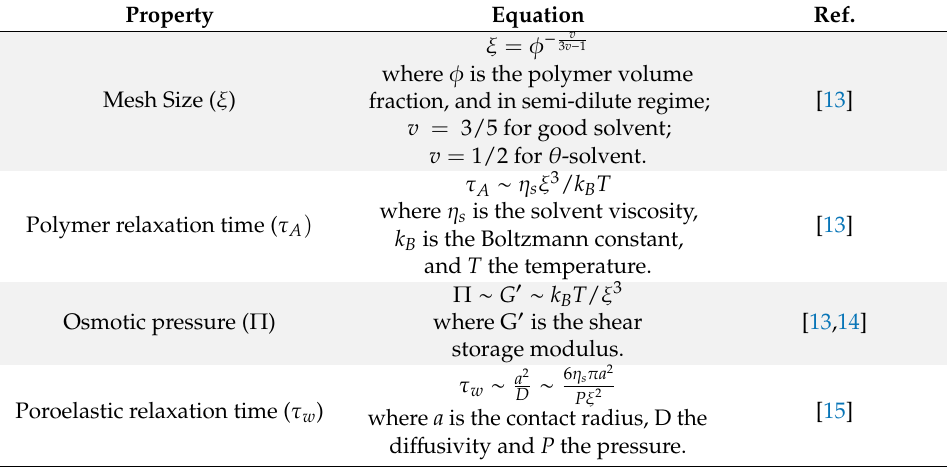
Figure 1. Hydrogel consisting of polymer chains permanently crosslinked or physically entangled. The mesh size ( ξ ) (see dashed circles) may vary as a function of the hydrogel’s depth due to gradients in crosslinking as well as polymer concentration. Table 1. Characteristic properties of hydrogels: mesh size ( 𝜉 ) , polymer relaxation time ( τ A ) , osmotic pressure ( Π ) and poroelastic relaxation time ( τ w ) .